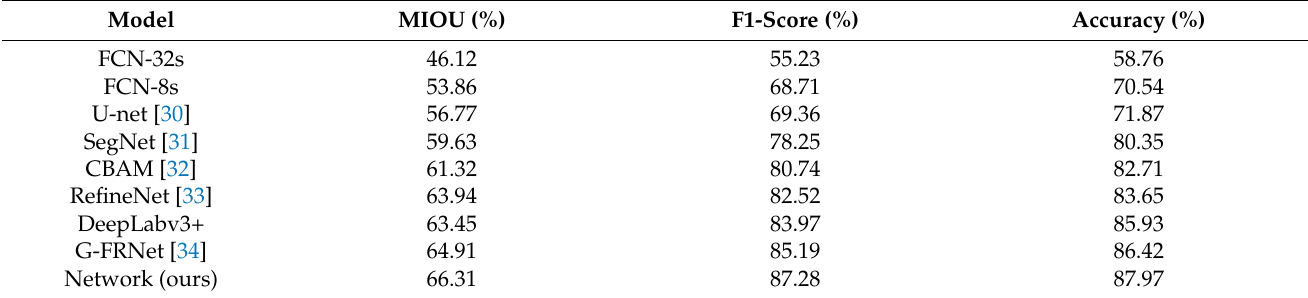
Table 1. Semantic segmentation results of long-grain rice dataset. The index results of MIOU, F1-score and accuracy of each algorithm.